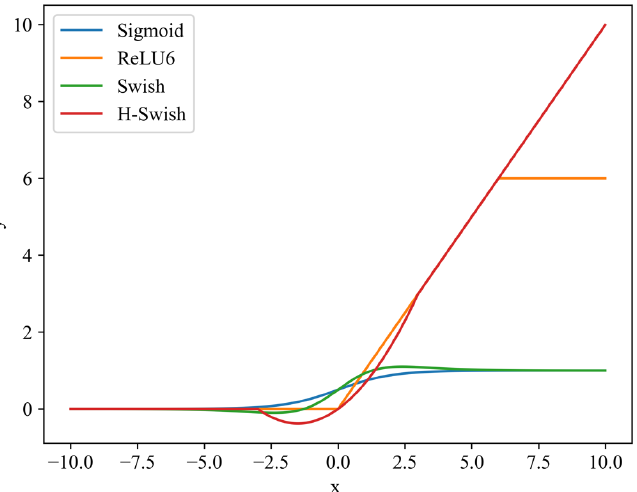
Figure 5. P Performance of various activation functions. x -axis is the input parameters of the activation, and y -axis denotes the output result of the activation function, namely y = h-swish [x]. Then, the feature maps were encoded by combing batch normalization (BN) and non- Linear. f is split into two tensors along the spatial dimension: f h ∈ R C×H and f w ∈ R C×W . Two 1 × 1 convolutional transformation functions F h and F w were used to transform f h and f w into tensors with the same dimensions as those of the input X .